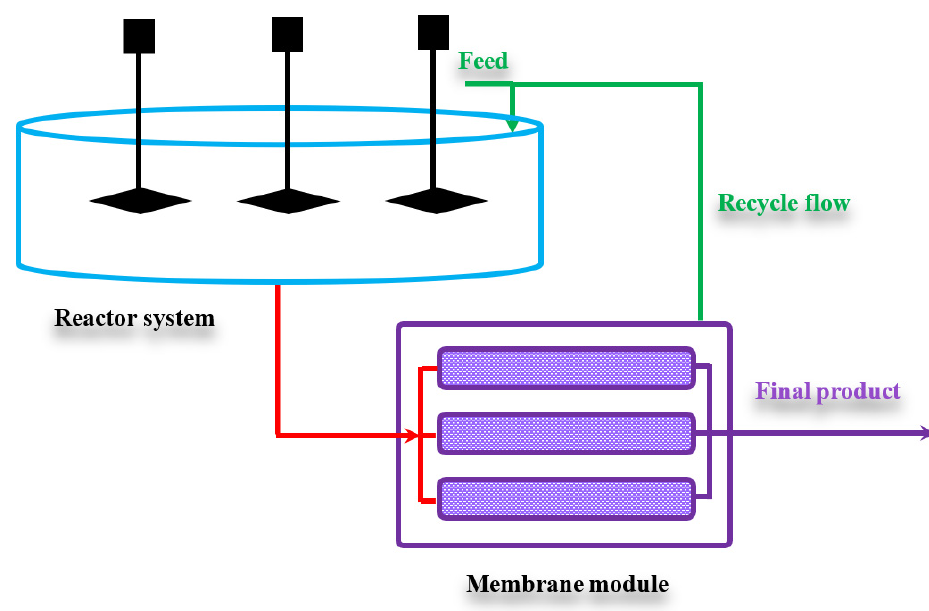
Figure 9. Schematic of the membrane reactor membrane system. Table 5. FAME composition of chicken feet oil